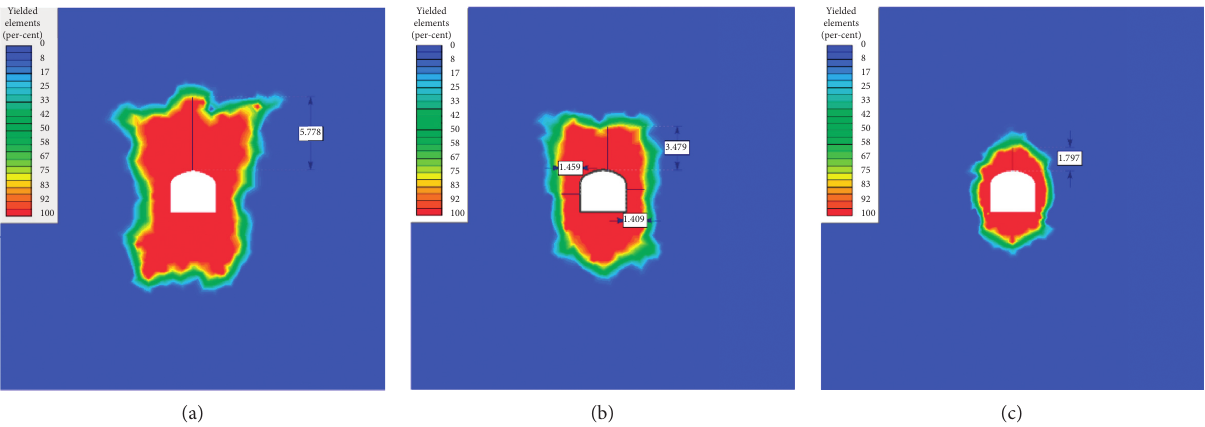
Figure 8: The shape and height of predicted yielding zone in weak rock drift according to various friction angles. (a) ∅ � 26.6 ° . (b) ∅ � 34.6 ° . (c) ∅ �